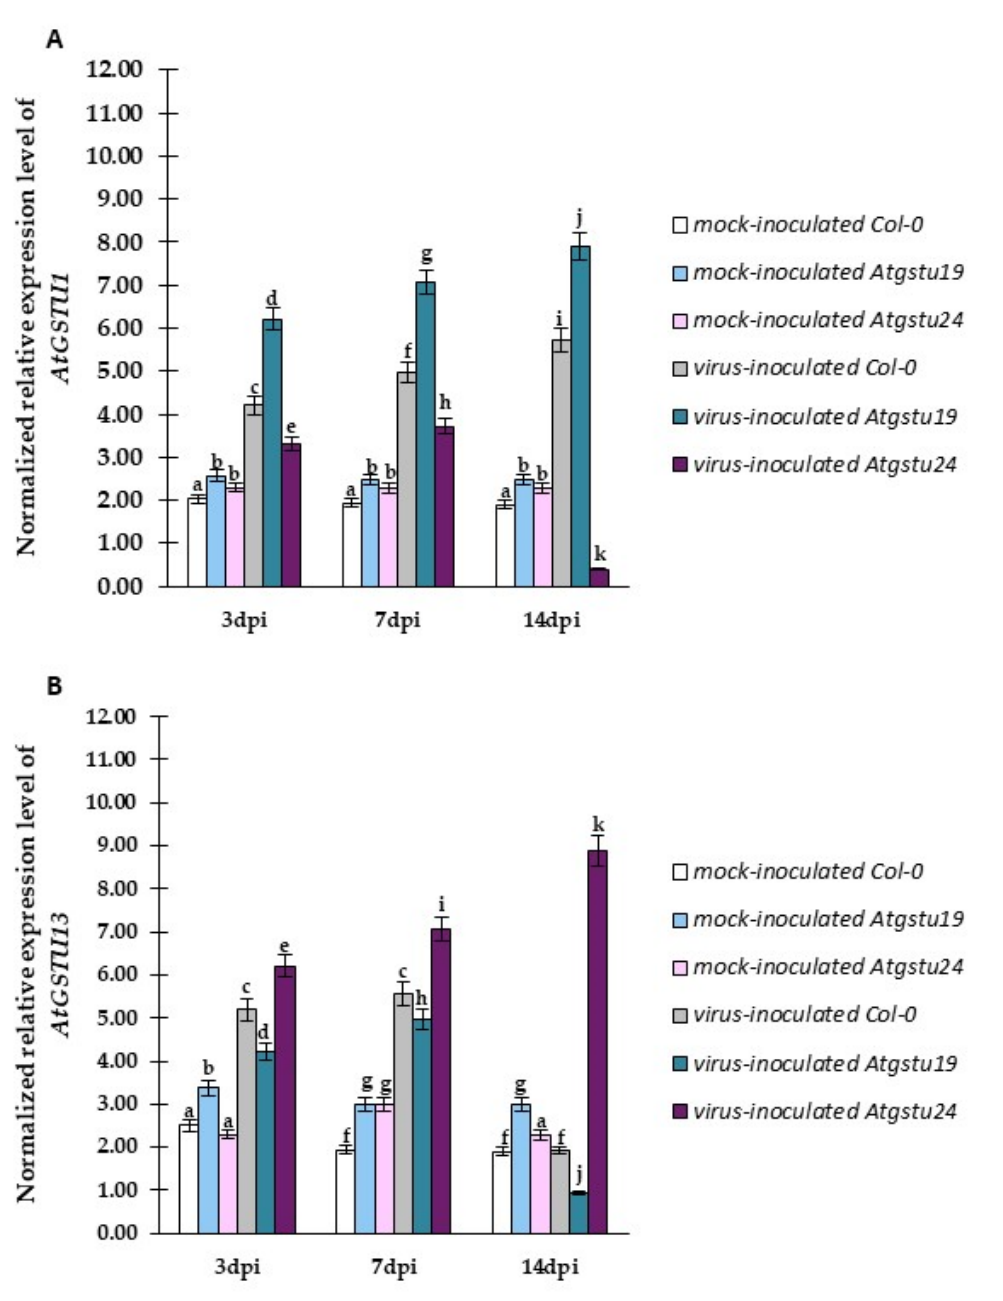
Figure 8. The normalized relative expression levels of AtGSTU1 ( A ) and AtGSTU13 ( B ) calculated based on the mean expression of AtEf1 α and AtF-Box reference genes in mock- and virus-inoculated Col-0, Atgstu19 , and Atgstu24 plants between 3 and 14 dpi. The mean values of the normalized expression levels were calculated using ANOVA and Tukey’s HSD test at p < 0.05. Statistically significant values are indicated by letters above the bar.